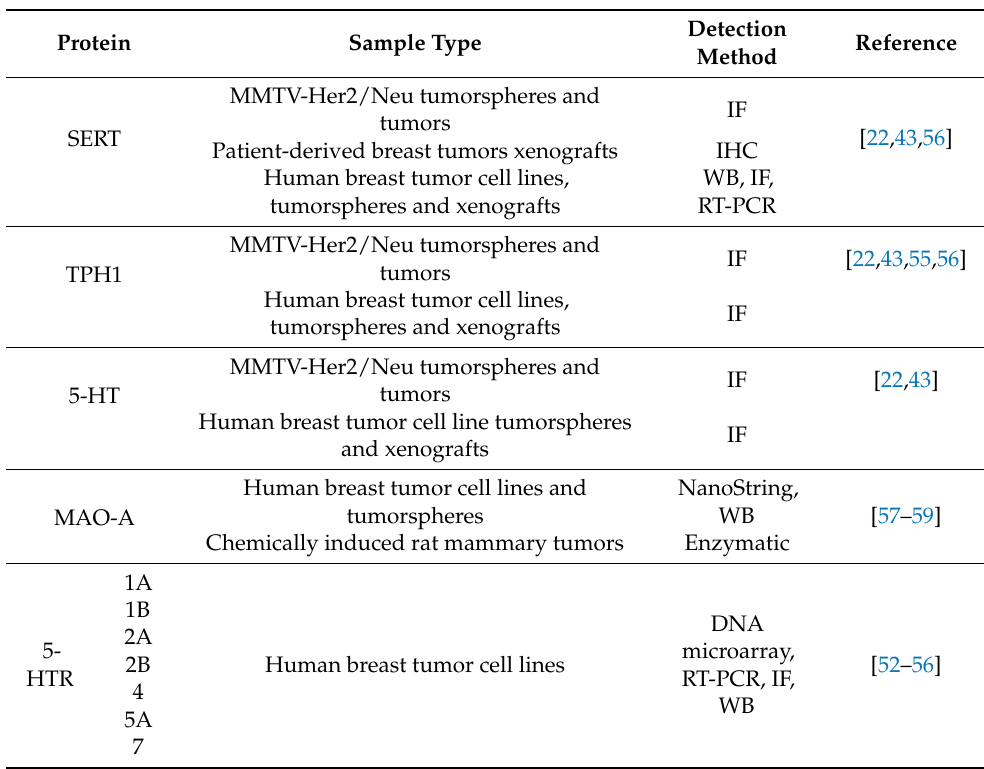
Table 1. Summary of serotonergic proteins expressed in breast